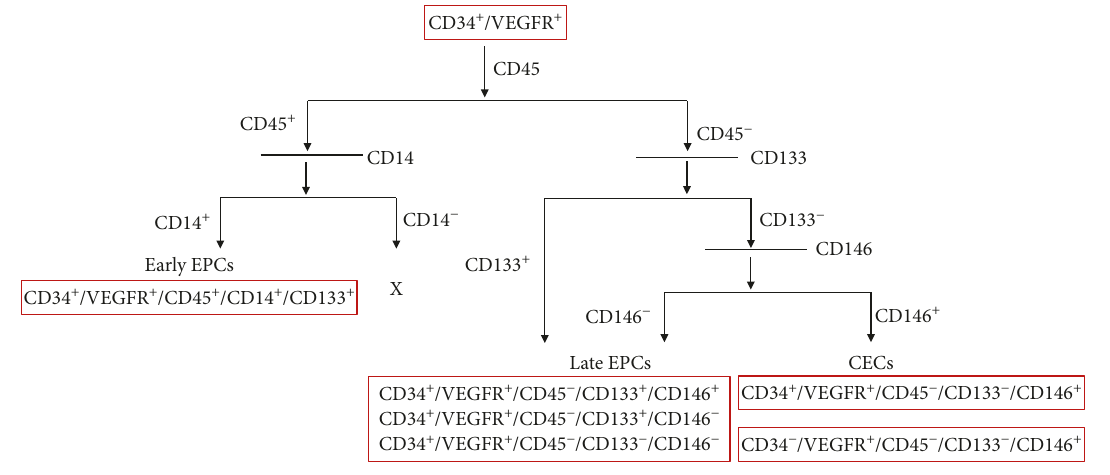
Figure 5: Phenotypic identity of